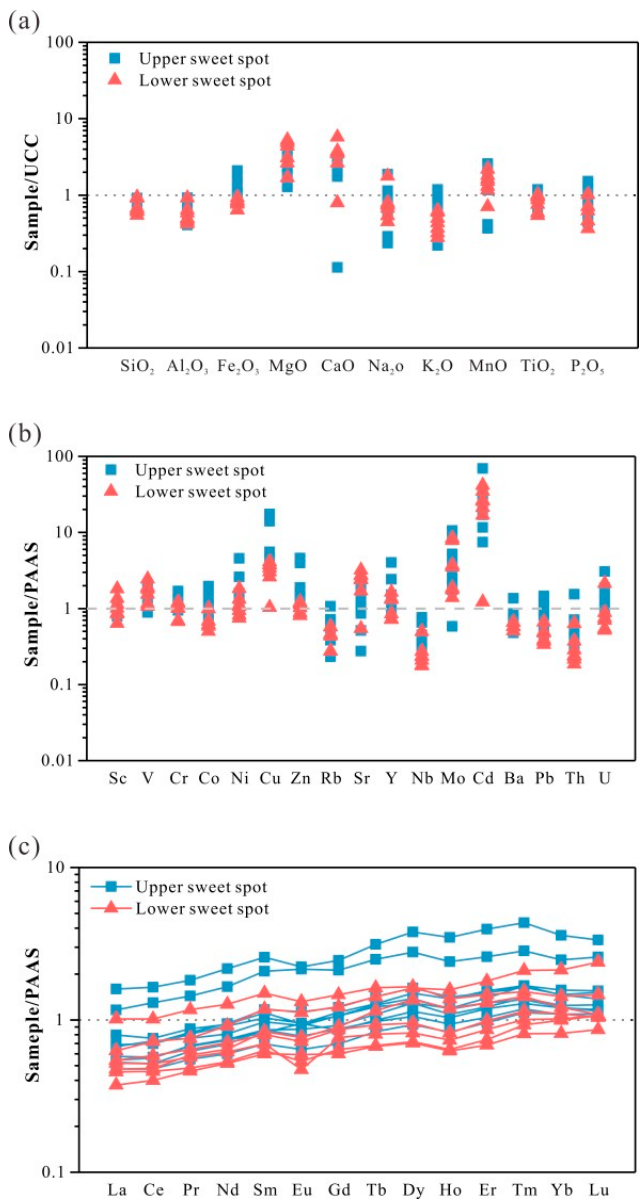
Figure 9. Plot of the enrichment index of ( a ) the major elemental oxides (relative to the upper continental crust); ( b ) trace elements; and ( c ) rare earth elements (relative to the Post-Archean Australian shale average) in upper and lower sweet spot source rocks. The dashed line represents an enrichment index with a value of 1.